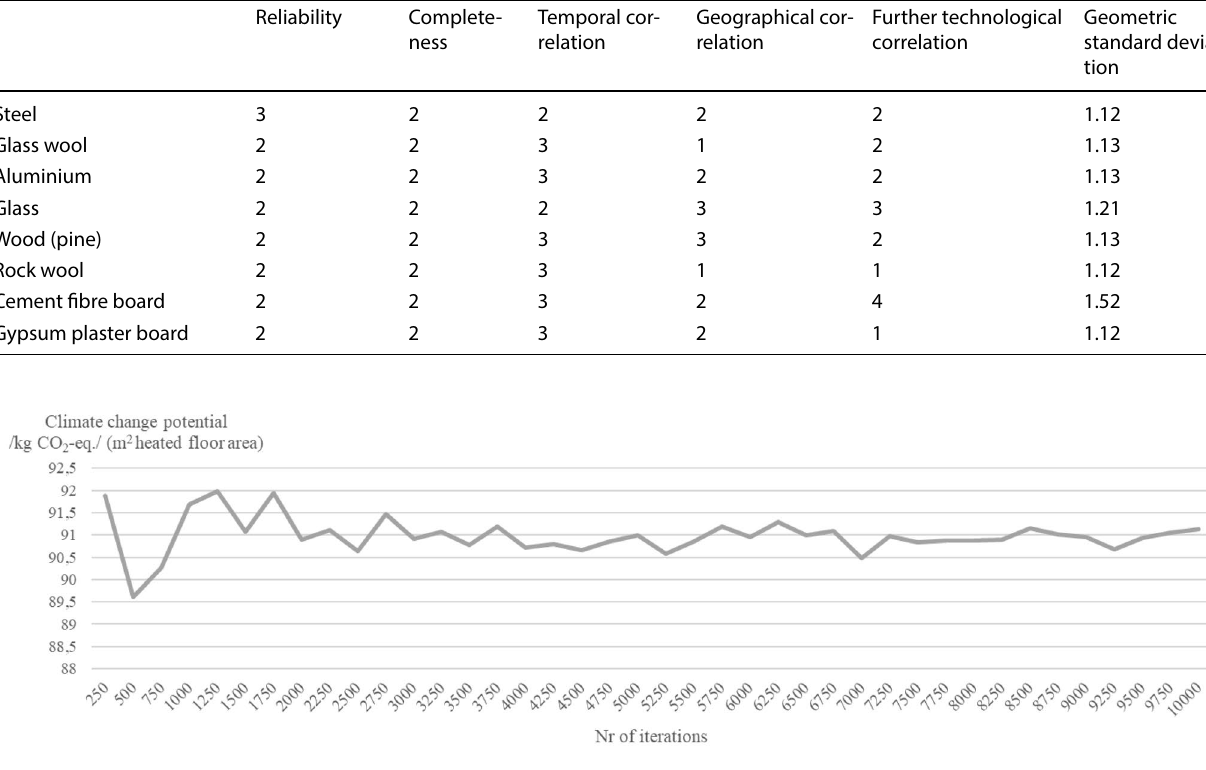
Fig. 2 Results from Monte Carlo simulations with 250–10,000 iterations